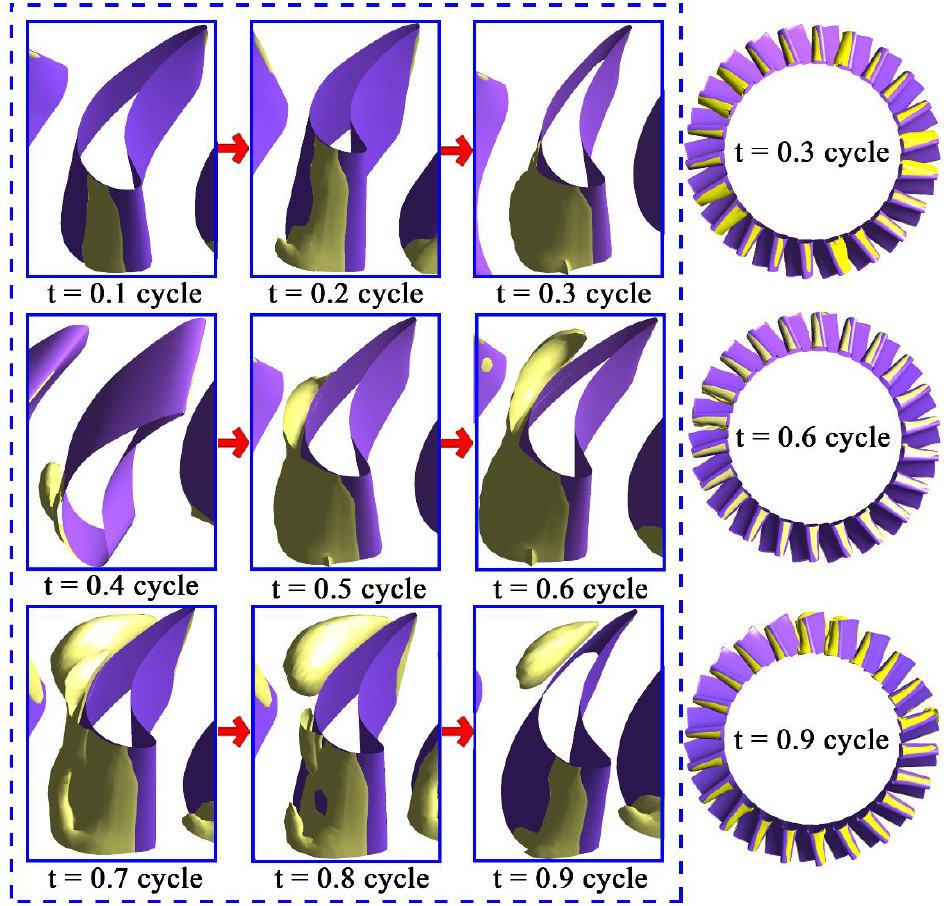
Figure 5. Periodic cavitation process in stator domain under stall operating condition.